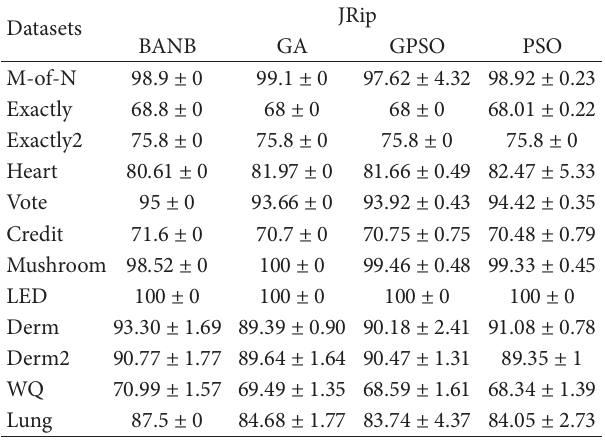
Table 4: Average classification accuracy with standard deviation for JRip.